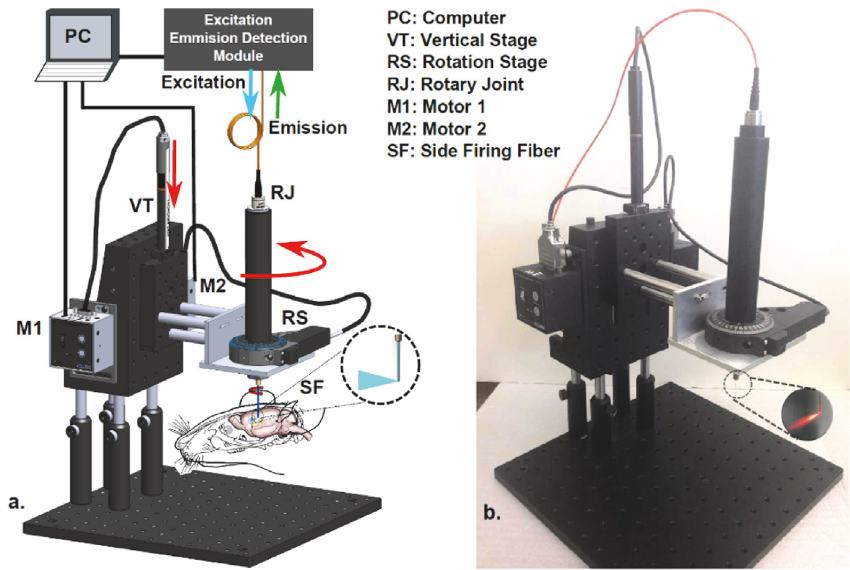
Figure 1: (a) Schematicof the setup: two computer controlled actuatorsadjust the position and orientation of a side-firing optical fiber inside the tissue. A fiber rotary joint is used to help rotate the fiber with no mechanical stress. At each position, the system sends an excitation laser pulse and detects a sample of the corresponding emission signal. Next, the collected data is processed by a computer to generate images that show the distribution of fluorescence signal in a cylinder surrounding the fiber; (b) picture of the developed